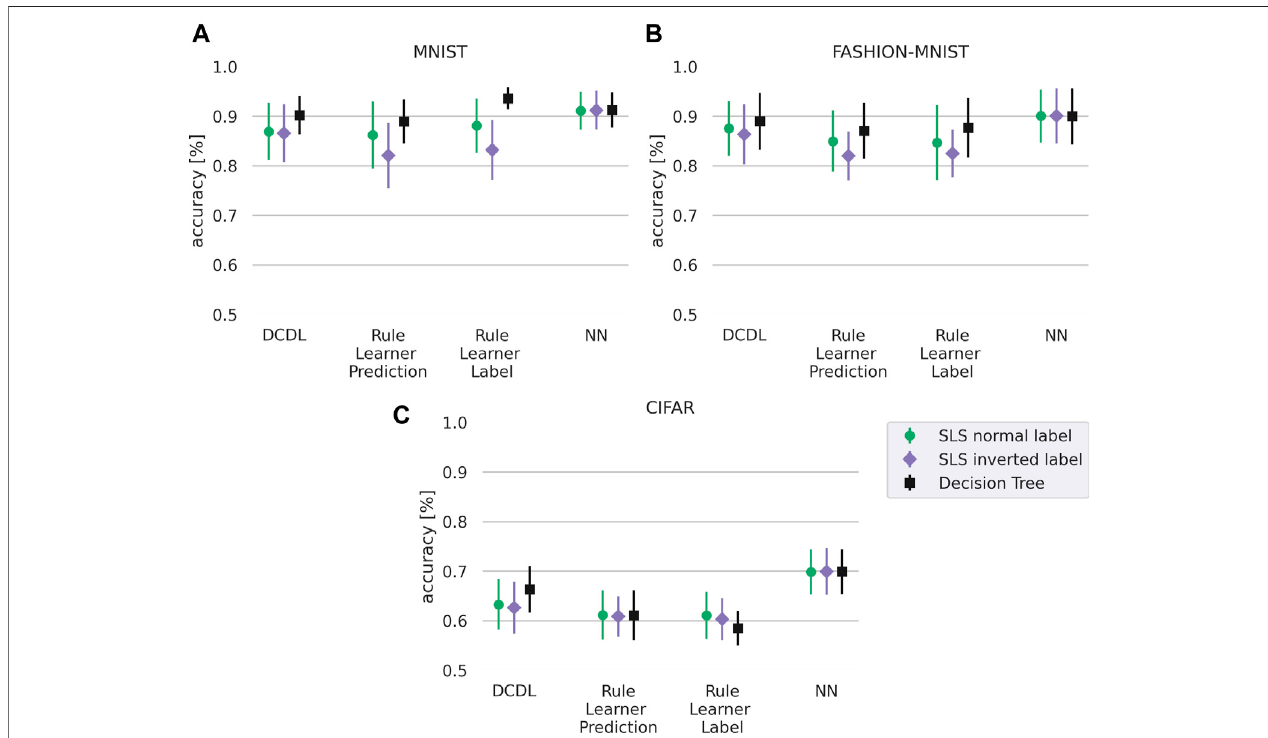
FIGURE 5 | Accuracy for different datasets with normal label and inverted label of our DCDL approach, a rule learner, a rule learner with true labels, and the neural network. As rule learners we compare SLS with k (cid:2) 40 and decision trees. (A) : MNIST, (B) FASHION-MNIST, (C) : CIFAR. The standard deviation is calculated from 30 runs overall, 3 for each class. The numeric values are given in Table 10 in the Supplementary Appendix